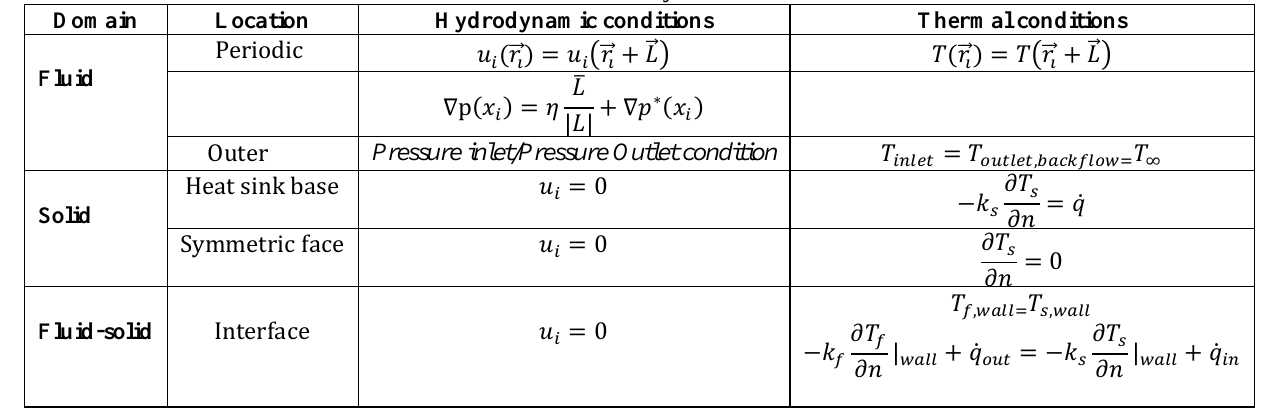
Table 2: Boundary conditions.